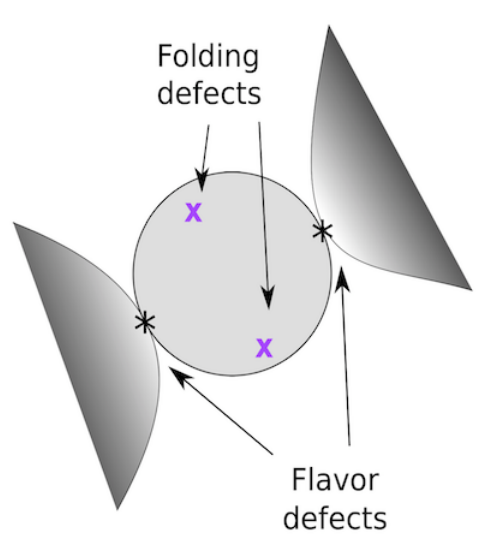
Figure 6. Generic geometry for a rank-one F-theory